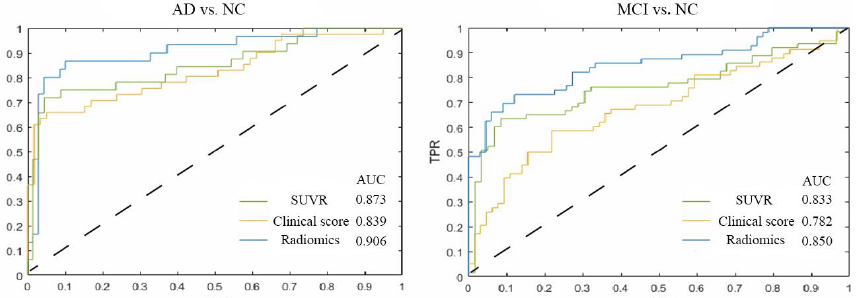
Figure 3. Receiver operating characteristic (ROC) curves in classification of AD vs. NC [AUC: SUVR 0.873 (0.847–0.913), Clinical score 0.839 (0.796–0.962), Radiomics 0.906 (0.850–0.933)] and MCI 0.873 (0.847 – 0.913), Clinical score 0.839 (0.796 – 0.962), Radiomics 0.906 (0.850 – 0.933)] and MCI vs. NC [AUC: SUVR 0.833 (0.797 – 0.859), Clinical score 0.782 (0.729 – 0.851), Radiomics 0.850 (0.802 –